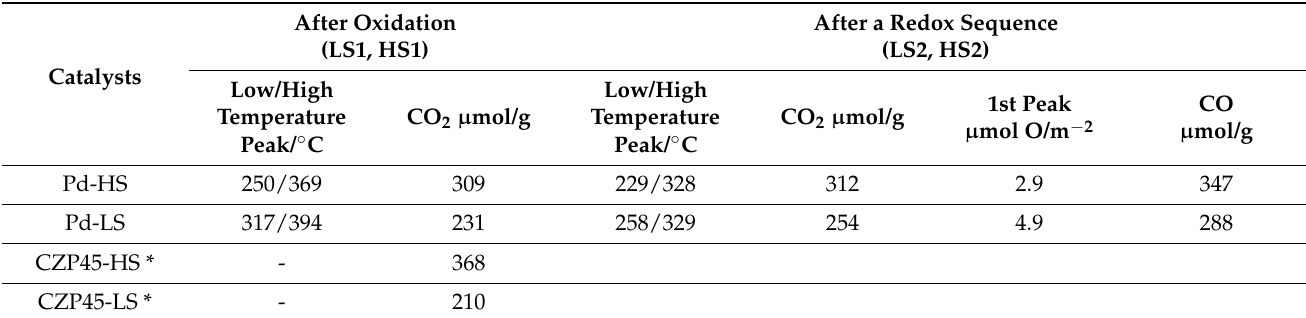
Table 3. Main characteristics of C 3 H 8 -TPR